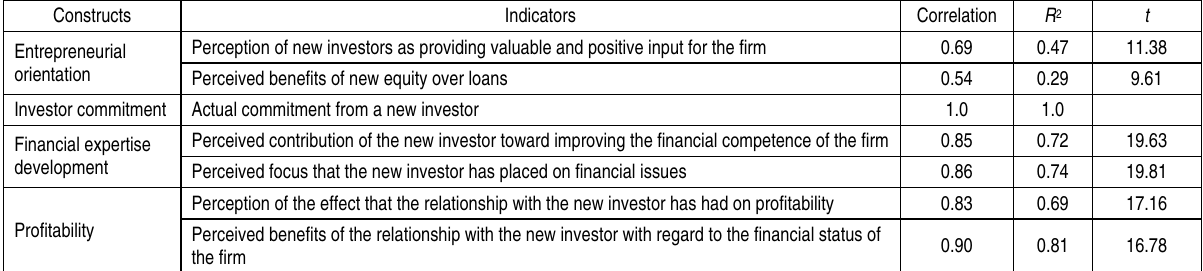
Table 2. The constructs and their indicators